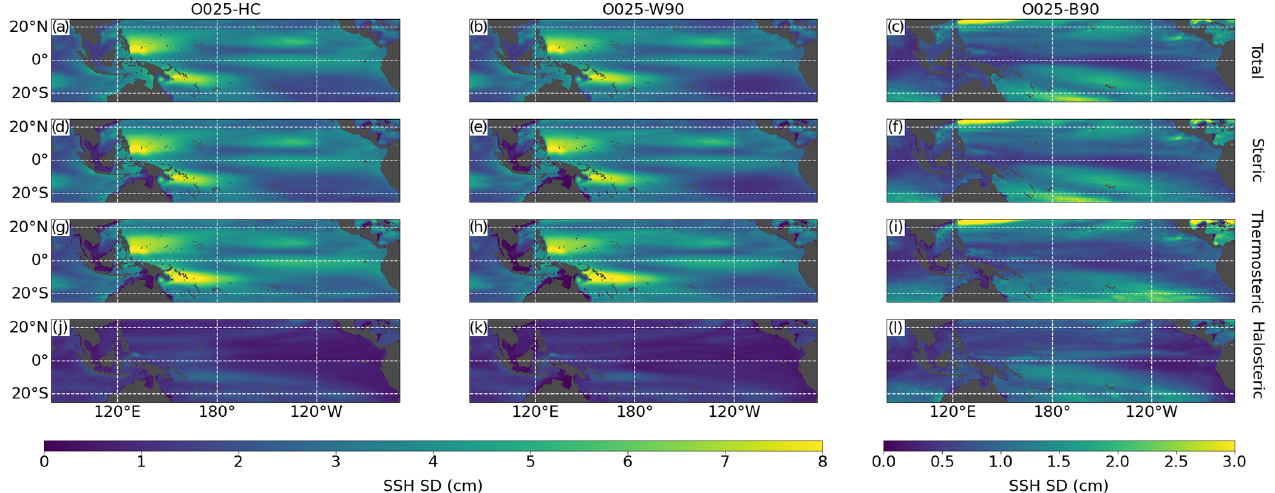
Figure 2. SD of total SSH (first row), steric SSH (second row), thermosteric SSH (third row) and halosteric SSH (fourth row) from O025-HC (left), O025-W90 (middle) and O025-B90 (right). SD is based on the period from 1958 to 2016. The global mean trends have been subtracted, and all data were smoothed with a 12-month running-mean window prior to